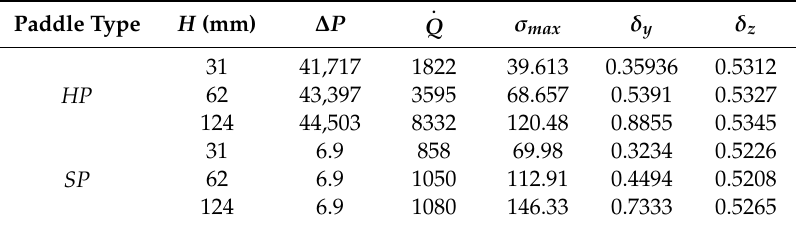
Table 7. E ff ects of height of paddles: h o = 250 W / (m 2 K), m =